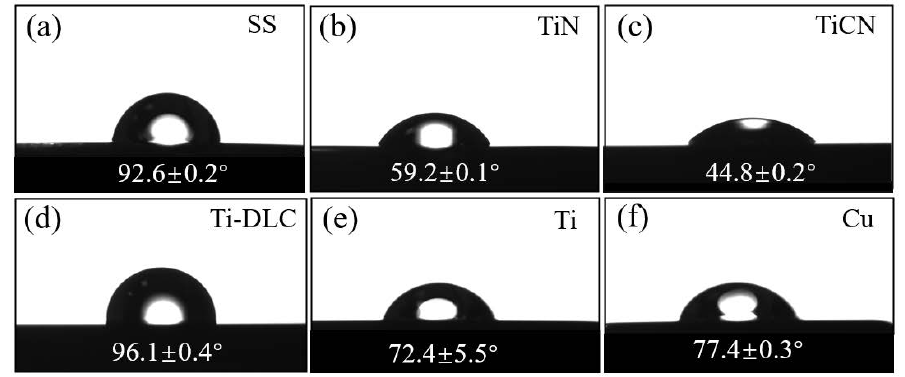
Figure 3. Water contact angle of ( a ) SS; ( b ) TiN; ( c ) TiCN; ( d ) Ti-DLC; ( e ) Ti; ( f )